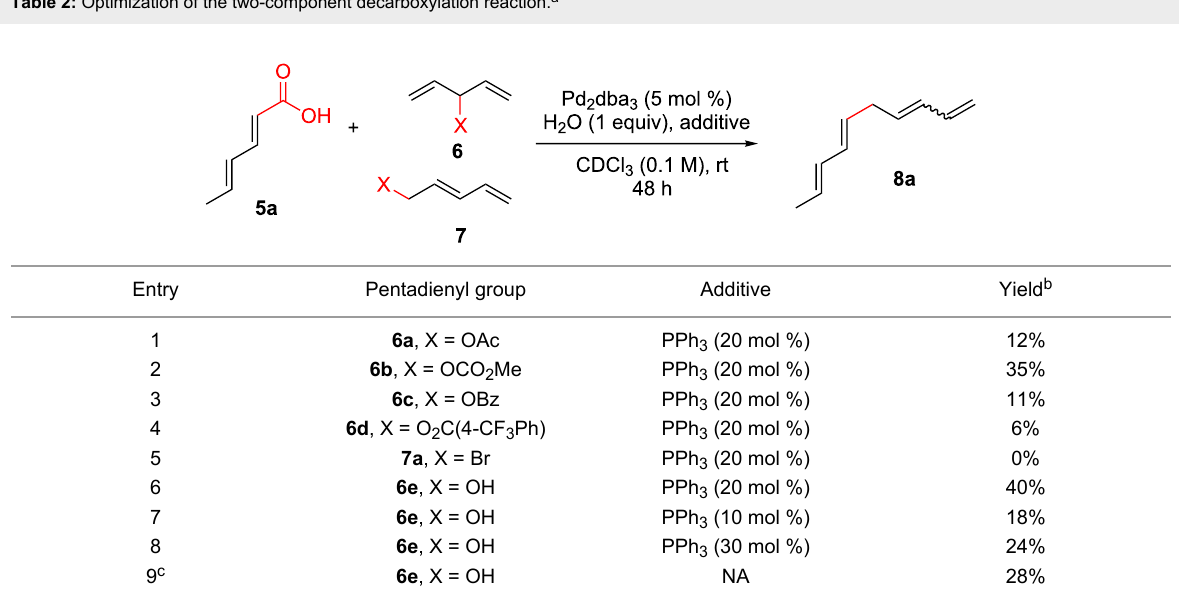
Table 2: Optimization of the two-component decarboxylation reaction.